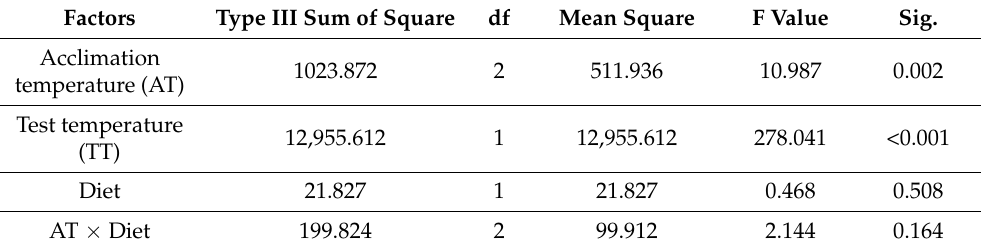
Table 2. Influences of temperature and diet acclimation on metabolic rate. The differences between groups were analyzed with ANCOVA, with test temperature as